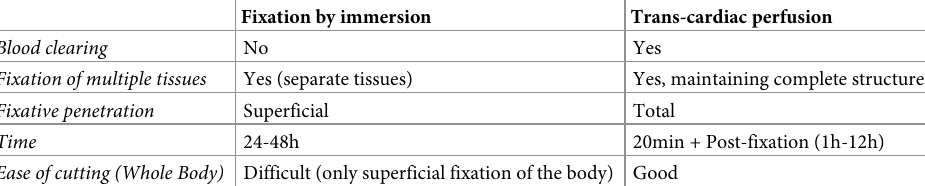
Table 1. Comparison between fixation by immersion and trans-cardiac perfusion.